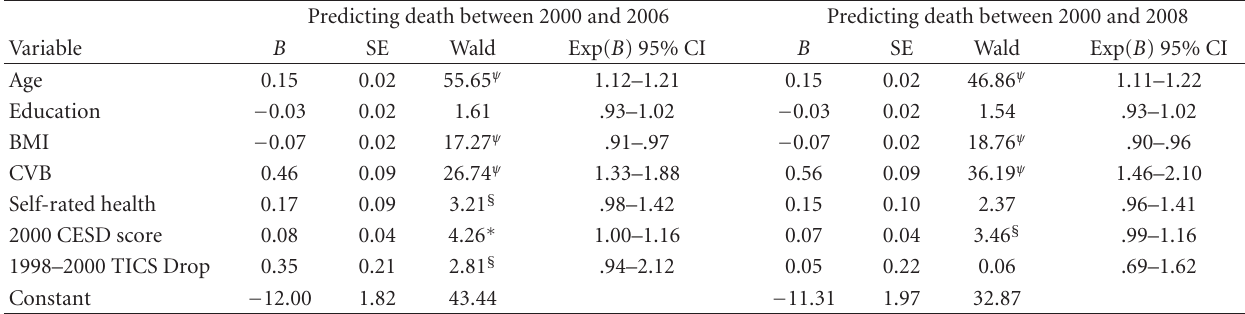
Table 2: Results of logistic regression predicting incidence of mortality between 2000 and 2006. Predicting death between 2000 and 2006